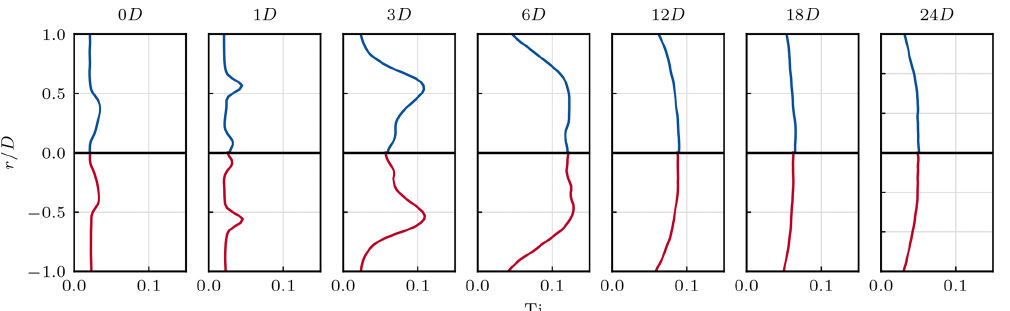
Figure 16. Cross-stream profiles of the turbulence intensity Ti of the CLBM and NS references in turbulent inflow. For the legend, see Fig. 12.